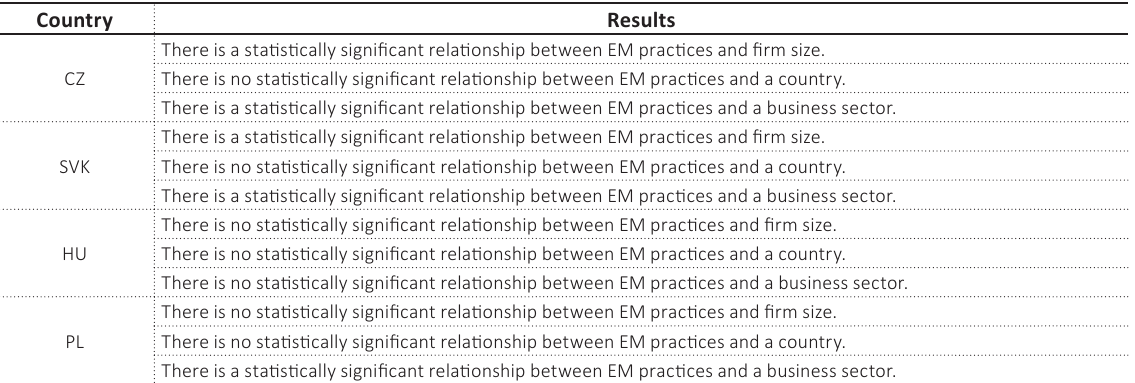
Table 6. Hypothesis testing